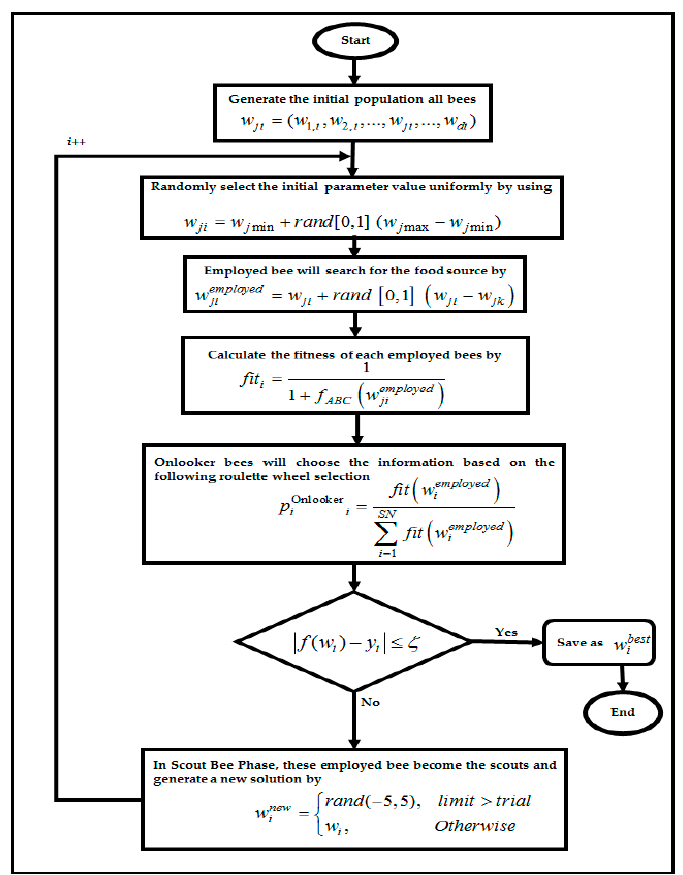
Figure 6. The artificial bee colony (ABC) algorithm implemented in RBFNN-2SATRA.